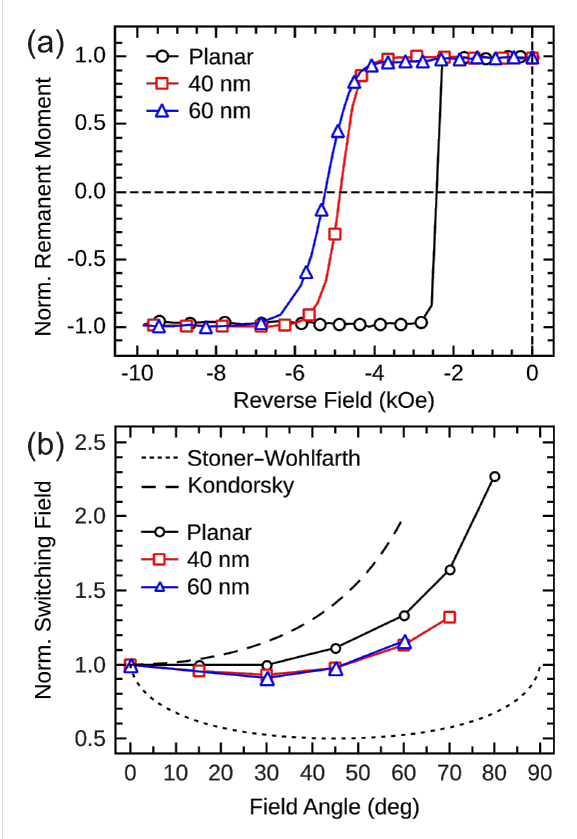
Figure 9: (a) MOKE remanence curves for Co/Pt multilayers grown on a planar substrate as well as on arrays of Au nanoparticles of 40 and 60 nm diameter. (b) Angular dependence of the switching field for the samples. The values beyond 60° for 60 nm particles and beyond 70° for 40 nm particles are not plotted, since the samples were not satu- rated in the available field. The figure has been reproduced with permission from reference [29] – Copyright 2009